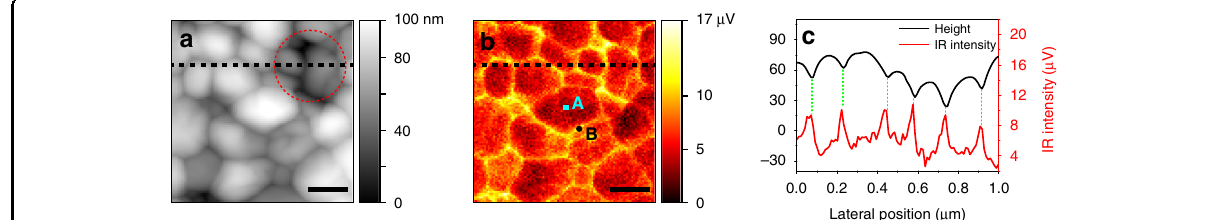
Fig. 1 Infrared near- fi eld images recorded on a CH 3 NH 3 PbI 3 /FTO/glass sample. a Topography image (1 μ m × 1 μ m). b Corresponding broadband infrared near- fi eld image, with the reference mirror fi xed at position d ≈ 0. Positions A and B indicate the regions of IG and GB, respectively. c One-dimensional near- fi eld amplitude and the topography line pro fi les along the black dashed lines in a and b . The optical signal intensity was recorded by the mercury-cadmium-telluride (MCT) detector so that signal in the unit of V was used. The scale bars in a and b are 200